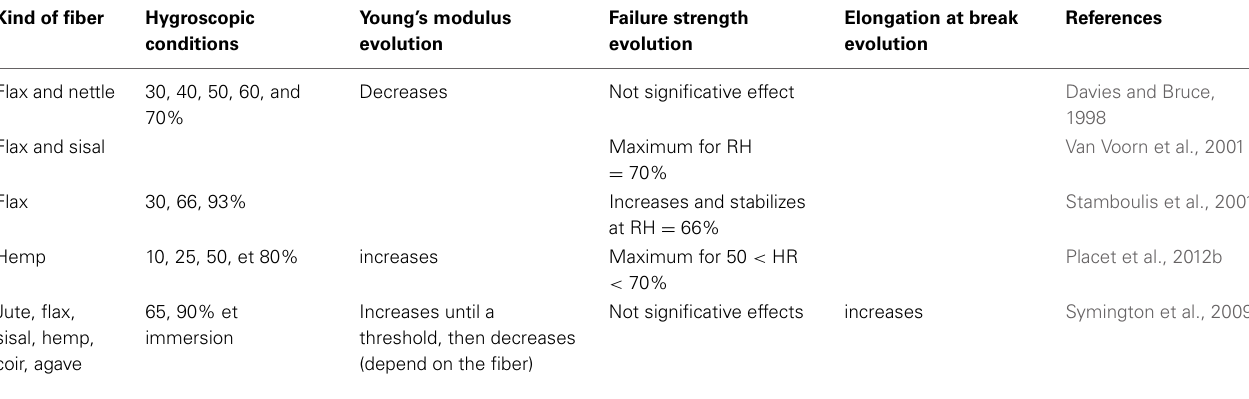
Table 3 | Literature review of the moisture absorption influence on the mechanical properties of plant